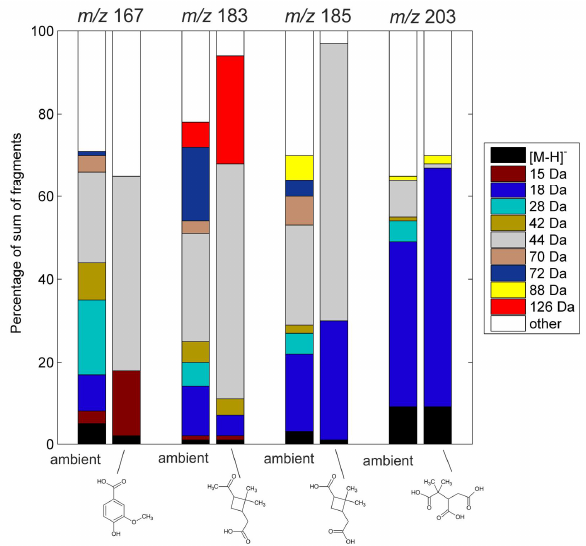
Fig. 5. Neutral losses of four distinct m/z ratios during online MS 2 Figure 5. Neutral losses of four distinct m/z ratios during online MS 2 on 22 July 2010 13:20-2 on 22 July 2010, 13:20–15:20LT (UTC + 2), compared with MS 2 15:20h (UTC +2) compared with MS 2 -spectra of authentic standards of vanillic acid ( m/z 3 spectra of authentic standards of vanillic acid ( m/z 167), cis -pinonic 167), cis -pinonic acid ( m/z 183) and cis -pinic acid ( m/z 185). The MS 2 -spectrum of MBTCA 4 acid ( m/z 183) and cis -pinic acid ( m/z 185). The MS 2 spectrum of ( m/z 203) is taken from an ambient filter sample measured with ESI-MS 2 after 5 MBTCA ( m/z 203) is taken from an ambient filter sample measured chromatographic separation. 6 with ESI-MS 2 after chromatographic